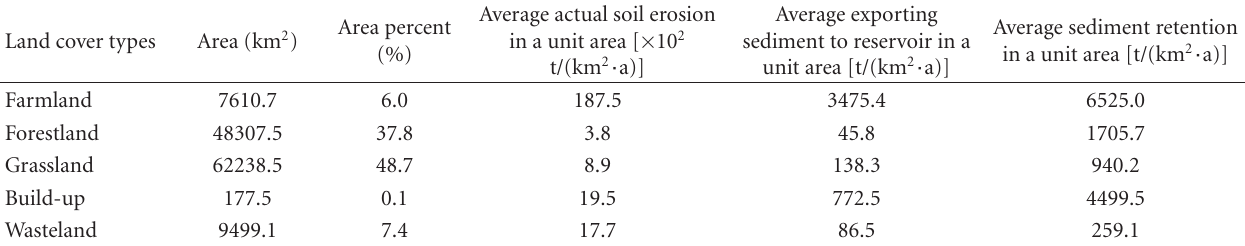
Table 2: The average soil erosion, exporting sediment and sediment retention of di ff erent types of land cover in 2005.